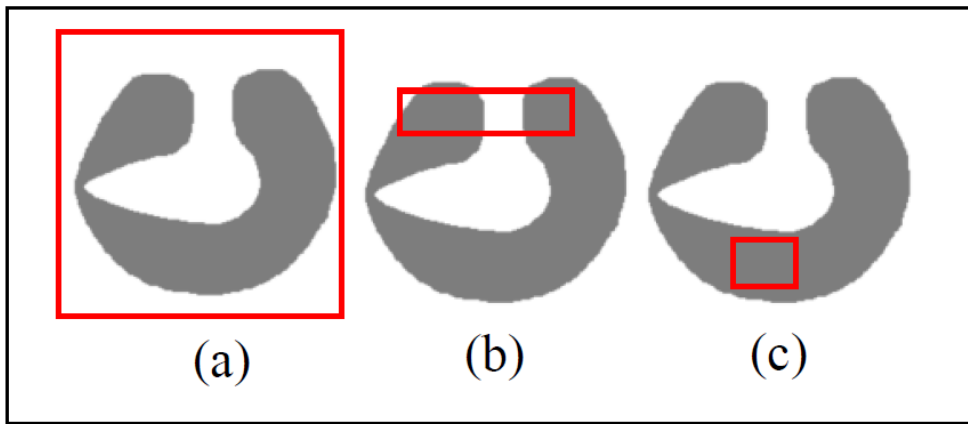
Figure 2. Three examples of initial contours considered outside ( a ), overlapping ( b ), and inside ( c ) the im-